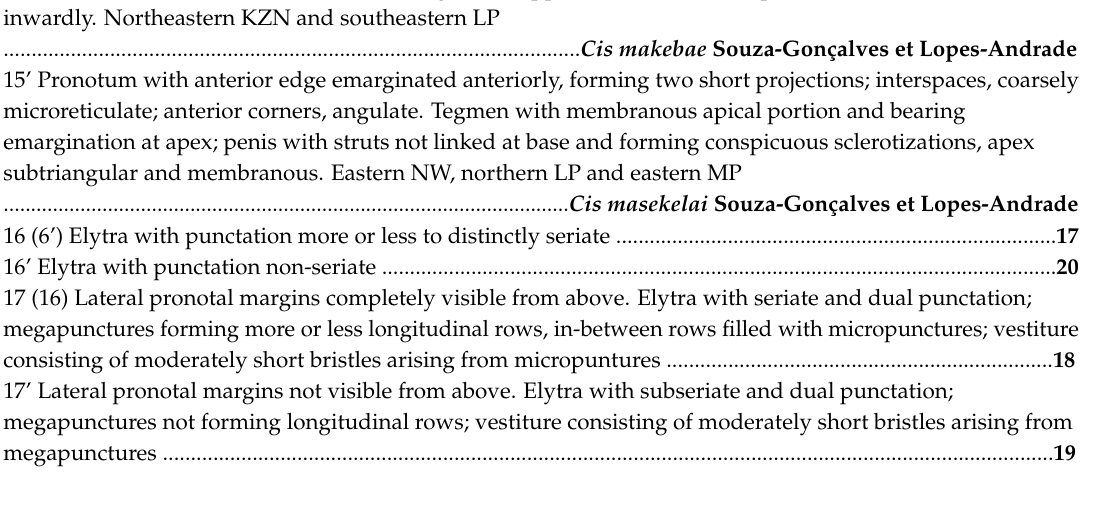
inwardly. Northeastern KZN and southeastern